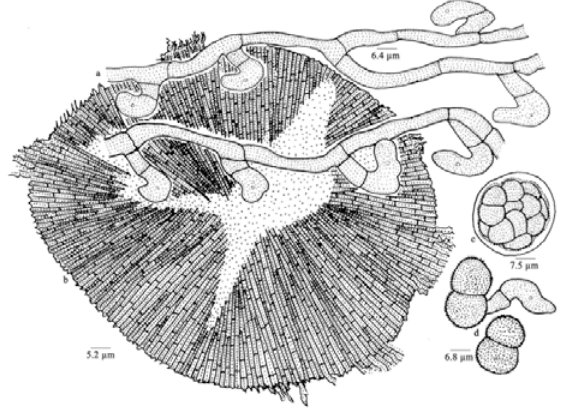
Figure 165. Asterina sarcandrae a - Appressorium; b - Thyriothecium; c - Ascus; d - Ascospores